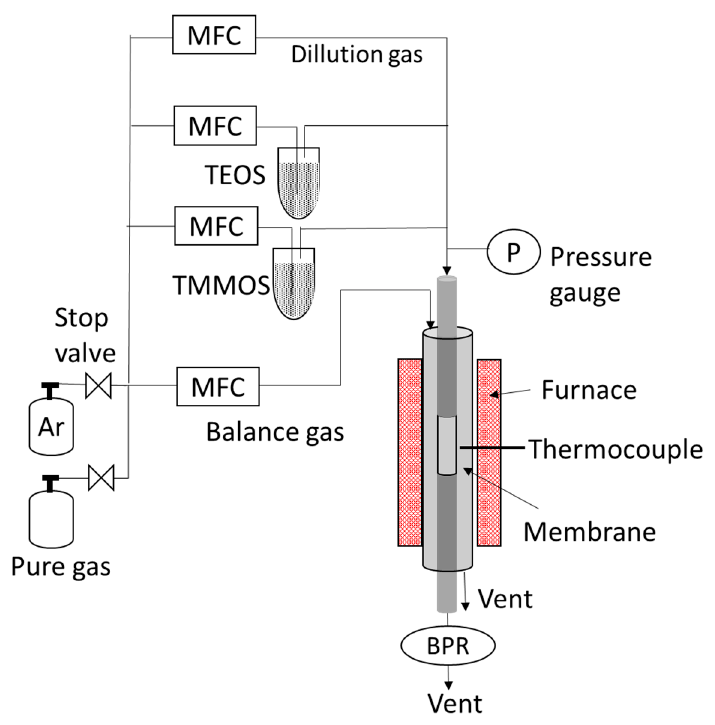
Figure 2. Schematic of the chemical vapor deposition apparatus for membrane fabrications.